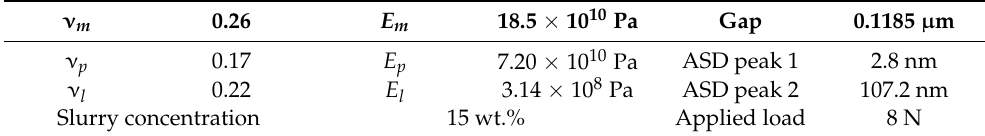
Table 3. Material and abrasive parameters for the micropolishing